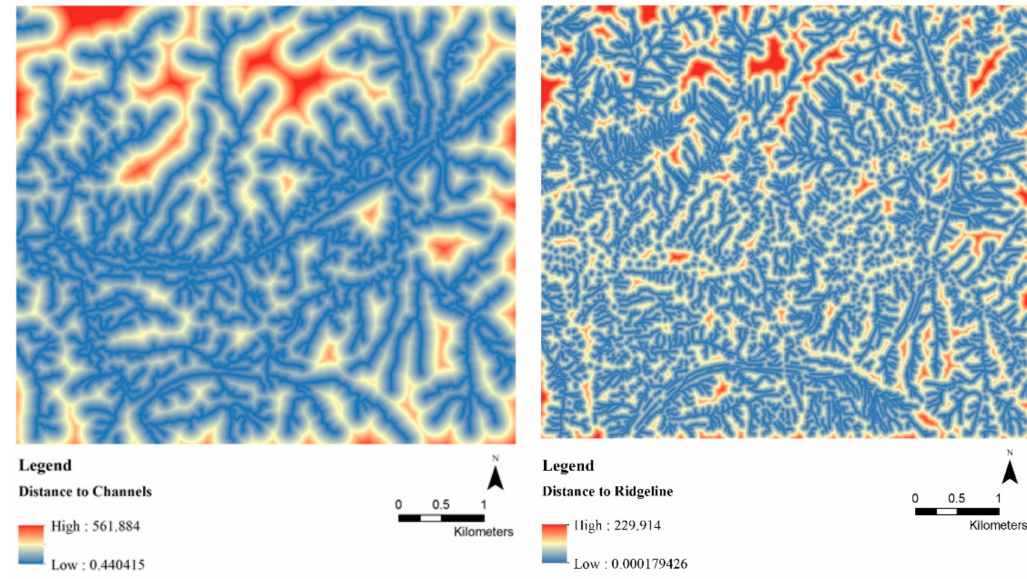
Figure 8. Distances to channels ( left ) and to ridgelines ( right ).